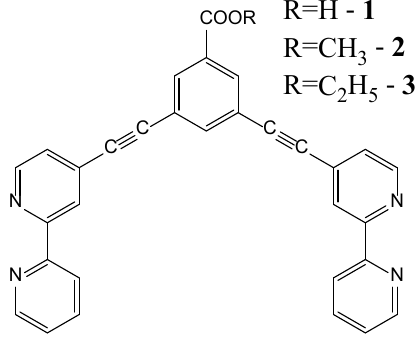
Figure 1: Structure of 3,5-bis(2,2-bipyridin-4-ylethynyl)benzoic acid - compound 1 and its methyl and ethyl esters ( 2 and 3